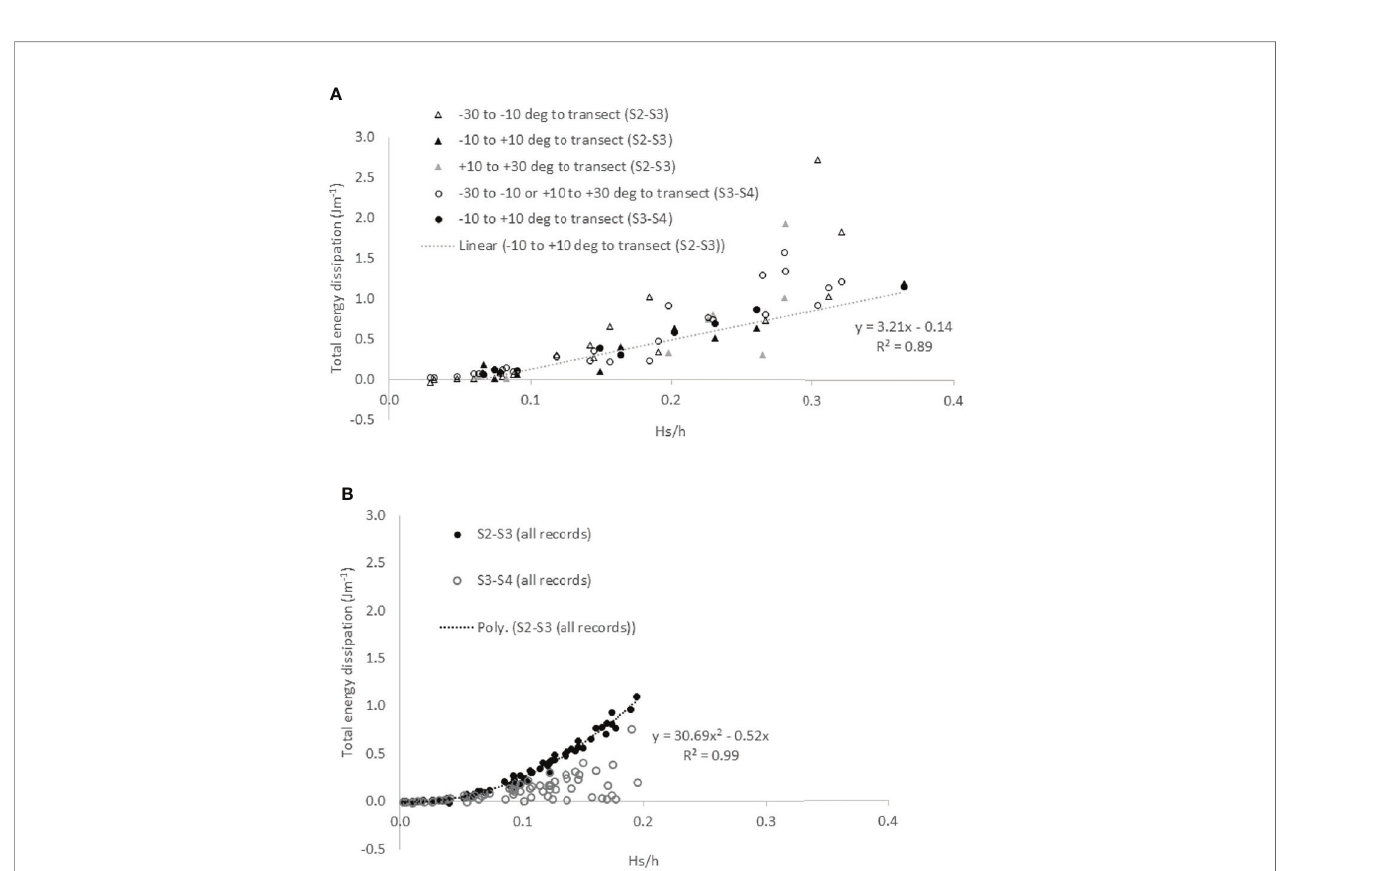
FIGURE 6 | Seasonal variation in mean dissipation coef fi cients ( k ) derived empirically from observed wave height dissipation between pairs of sensors (S2S3, S3S4, and S2S4; see Figure 3 for sensor locations) at (A) Histria and (B) Cape Dolosman. Error bars indicate ± 1 standard